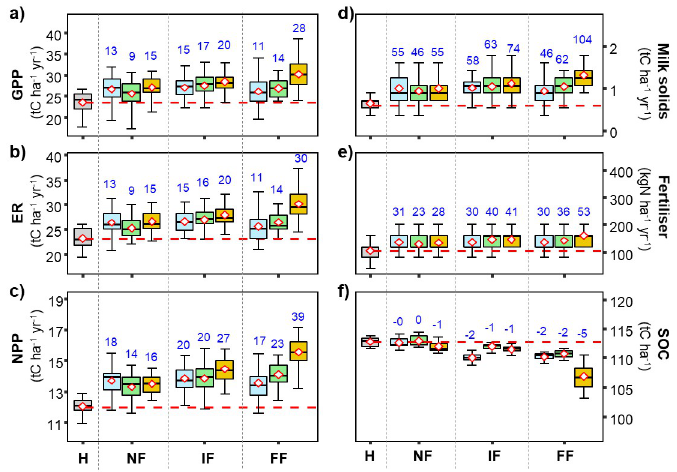
Fig 4. Box and whiskers charts for modelled GPP a), ER b), NPP c), Milk-solid production d), required N fertilizer application rates e) and SOC stocks f) under different future climate scenarios for the grazed grassland site. Model runs were done under different climate-change projections according to RCP 2.6 (blue), RCP 4.5 (green) and RCP 8.5 (orange). Driving variables included their respective atmospheric CO 2 concentration dynamics. Horizontal red dashed line and red numbers are the mean of the variable for the Historical period and blue numbers give the percent change of the annual variables means for the different scenarios and time horizons.